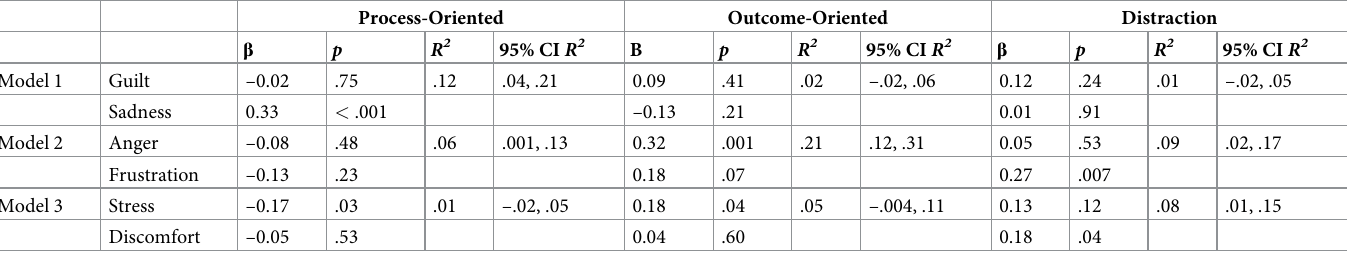
Table 7. Proportion of variance accounted for parenting behaviors by emotion groups—children’s unjustified